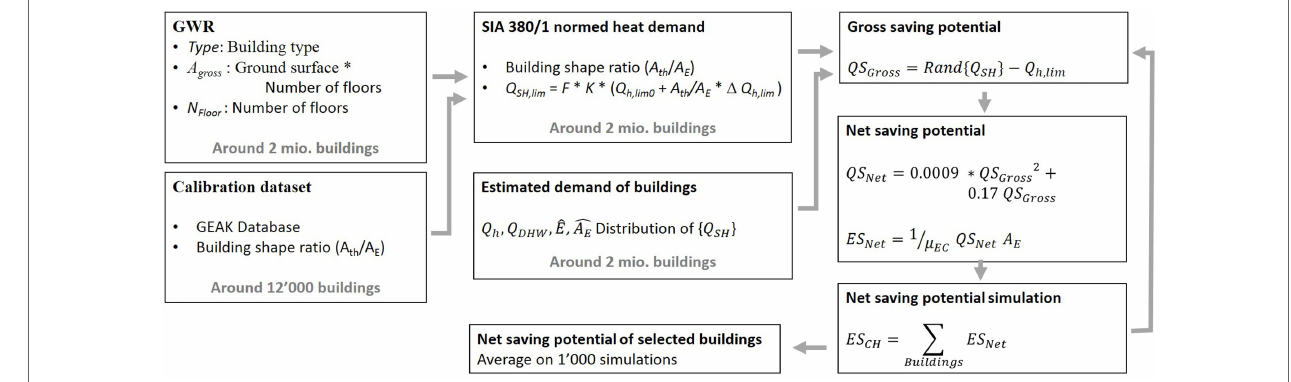
FIGURE 7 | Estimation of gross and net energy saving potential after retrofit of a building group.